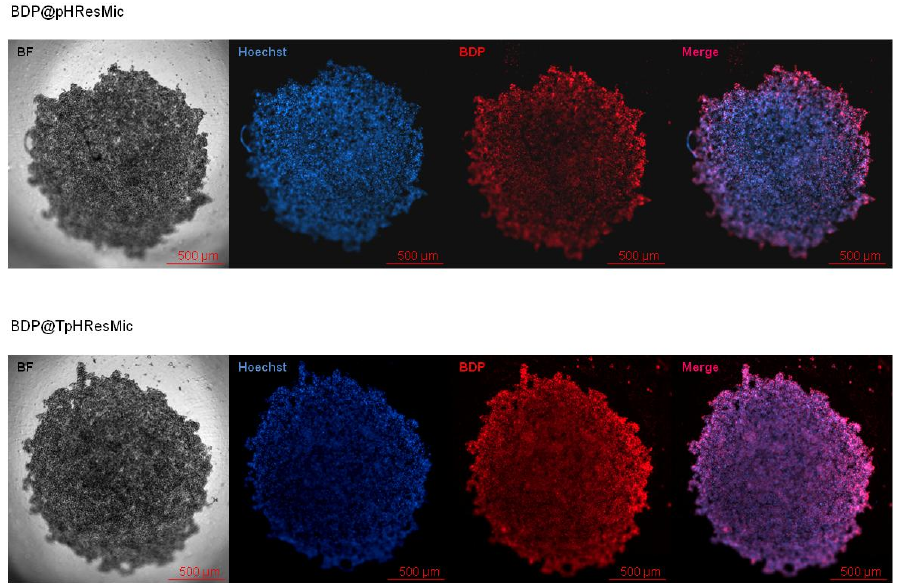
Figure 9. Fluorescence uptake studies on 3D model of PANC − 1 cells. The upper panel shows the bright field (BF) image of the spheroid, the fluorescence intensities of Hoechst (blue—nuclei), BDP (red—BDP@pHResMic), and a merge of them; the lower panel shows the bright field (BF) image of the spheroid, the fluorescence intensities of Hoechst (blue—nuclei), BDP (red—BDP@TpHResMic), and a merge of them. Scale bar 500 µm.